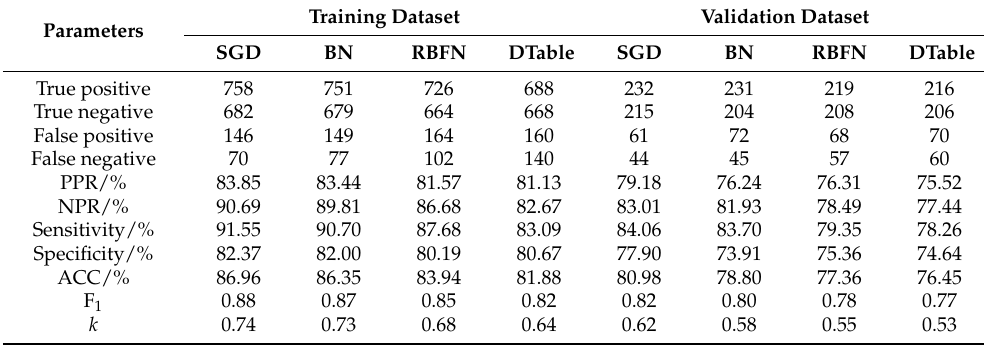
Table 3. Statistical index results of different models.